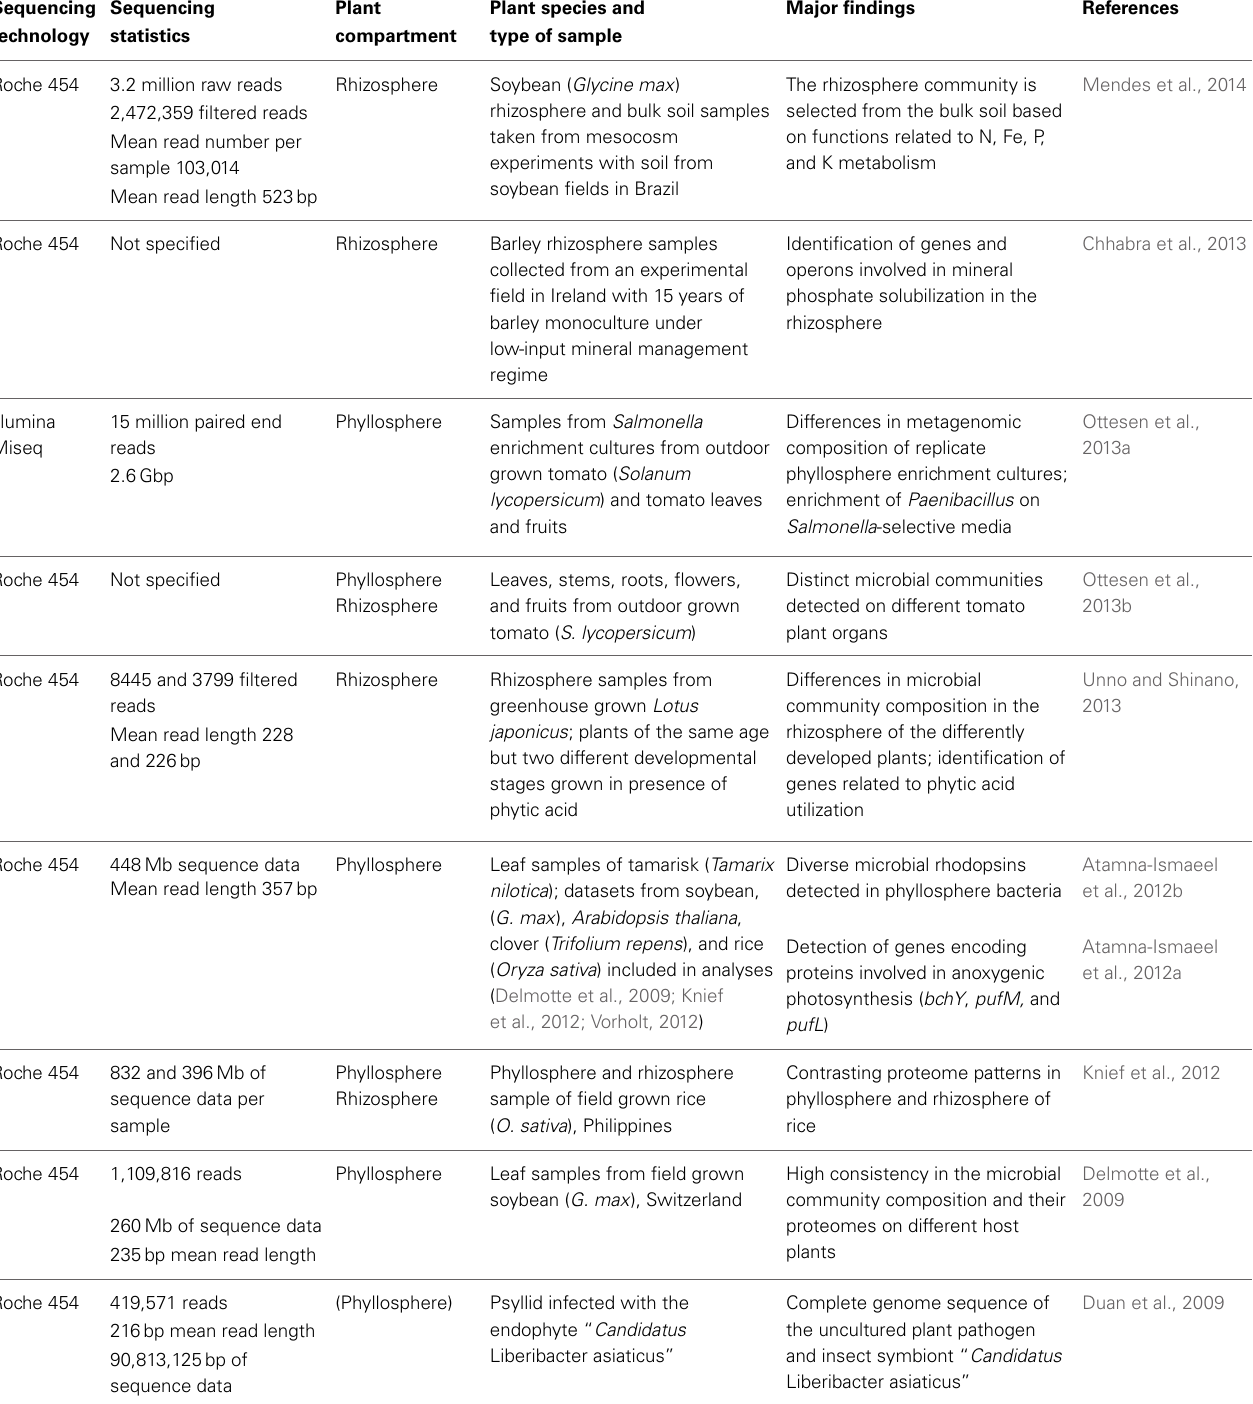
Table 3 | Metagenomic studies based on NGS technology that target the plant-associated microbiota. Sequencing